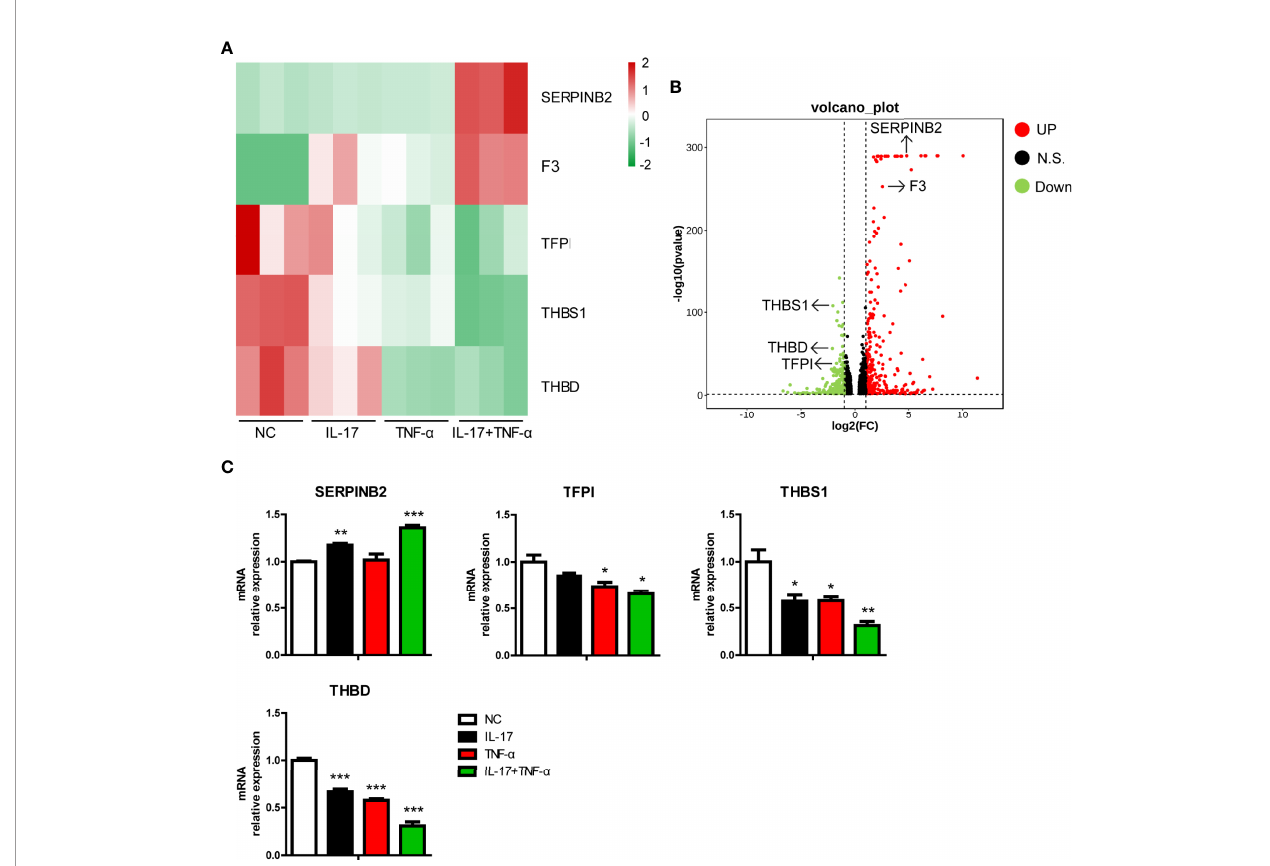
FIGURE 4 | IL-17 and TNF- a regulated coagulation-related gene expression in porcine aortic endothelial cells (PAECs). (A) Heat map showing regulated coagulation- related additive or synergistic genes (ASGs) in the control group, IL-17 group, TNF- a group, and IL-17 plus TNF- a group. (B) Volcano plots displaying regulated coagulation-related ASGs between the control group and the IL-17 plus TNF- a group. (C) The PAECs were treated with rhIL-17 (100 ng/ml), rhTNF- a (2 ng/ml), or rhIL- 17 plus rhTNF- a for 0 or 6 h. The induction of SERPINB2, TFPI, THBS1, and THBD mRNA was measured via real-time PCR. Data are representative of at least three independent experiments (mean ± SEM). * p < 0.05, ** p < 0.01, *** p < 0.001, determined by Student ’ s t